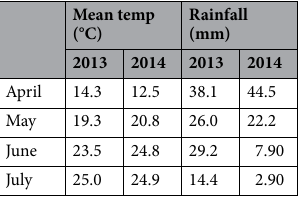
Table 1. Monthly mean temperature and monthly rainfall at Shihezi from April 1 until harvest in 2013 and 2014.